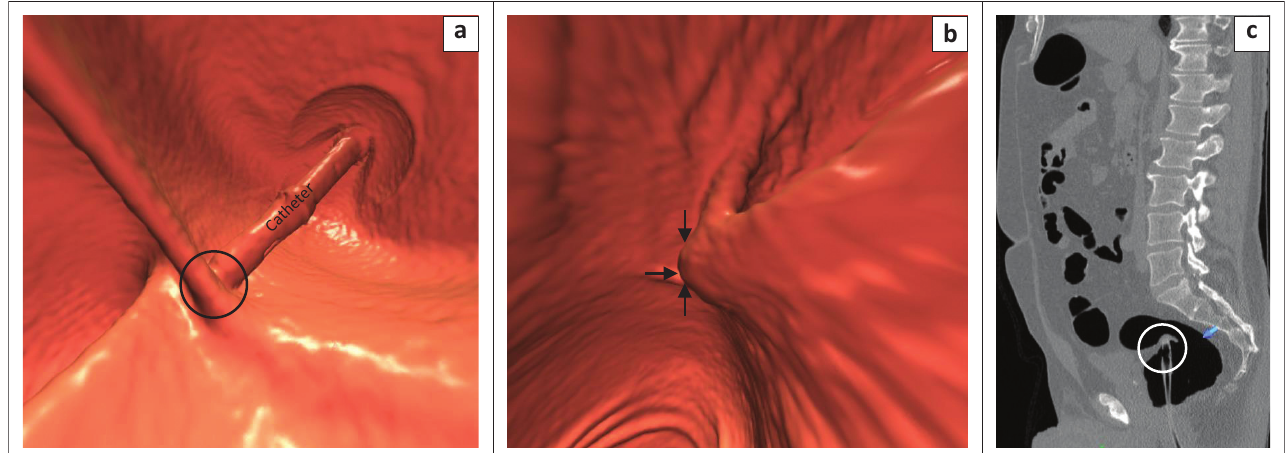
FIGURE 5: (a) 3D endoluminal view showing tube in direct contact with valve of Houston (black circle). (b) 3D endoluminal view showing tube causing a bulge on rectal mucosa (black arrows). (c) 2D sagittal view shows tube impinging on fold (white